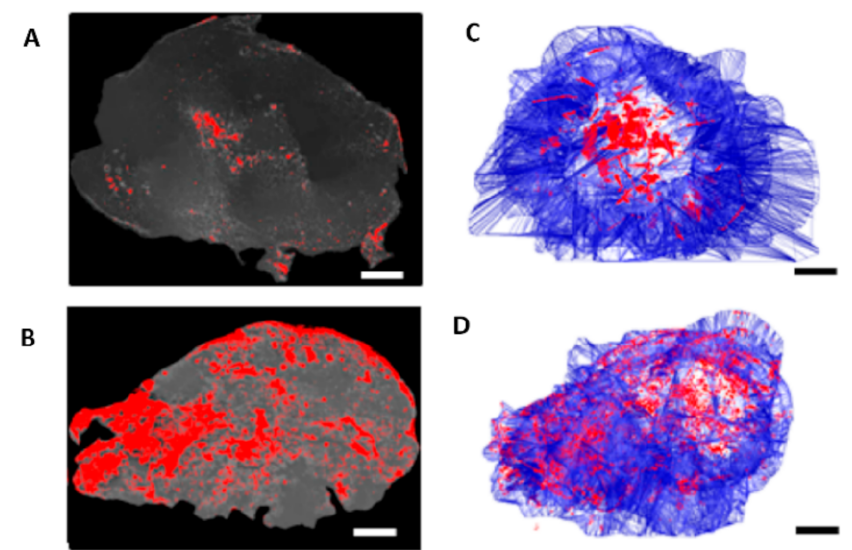
Figure 9. Comparison of free AuNRs’ and NSC-AuNRs’ distribution after intratumoral injection showed that NSCs caused a uniform distribution of AuNRs in the tumor. Three days after AuNR injection, tumors were sectioned and imaged using dark-field microscopy. ( A , B ) Mapped cross- sections of tumors injected with free AuNRs ( C ) or NSC-AuNRs ( D ). ( C , D ) 3D projection of all mapped AuNRs (red) and tumor (blue) traces generated using reconstruction software in tumors that received free AuNRs ( C ) or NSC-AuNRs ( D ) (Scale bar = 1 mm). Adapted with permission from